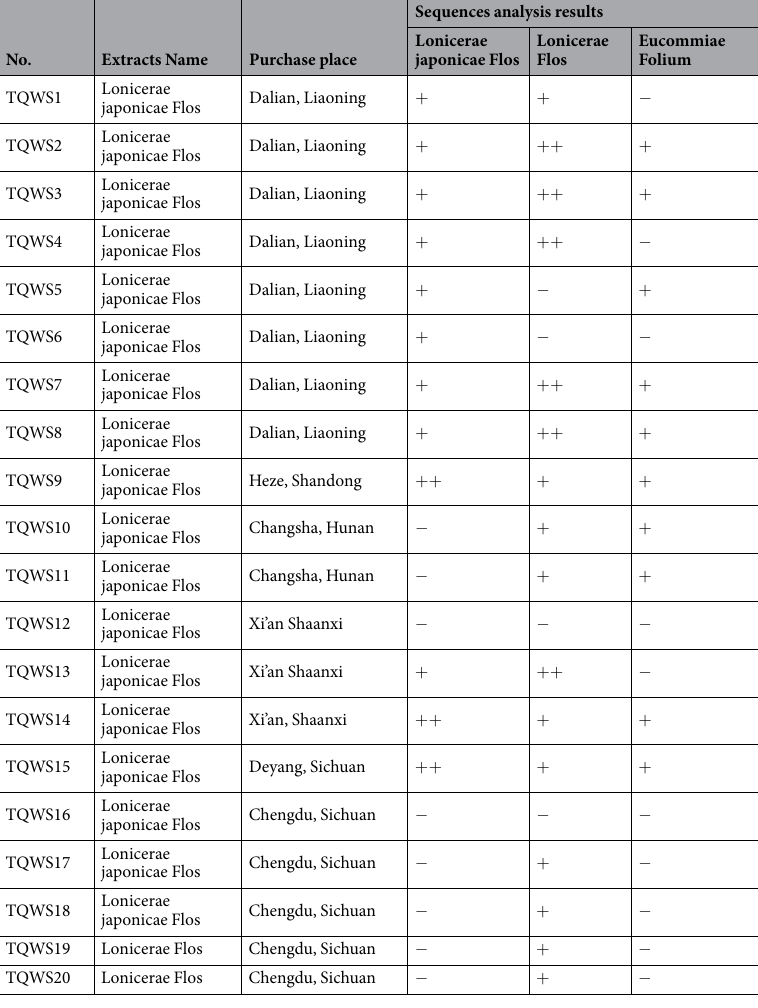
Table 1. Results of Lonicerae japonicae species extracts sequences analysis. “ + ” means contain the component “ − ” means without the component. “ ++ ” means contain more